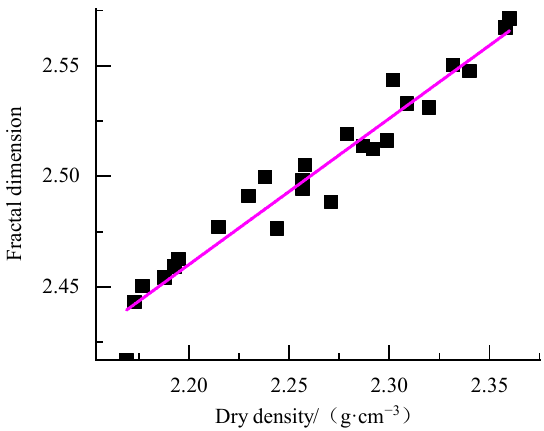
Figure 10. Correlation curve of fractal dimension and dry density.